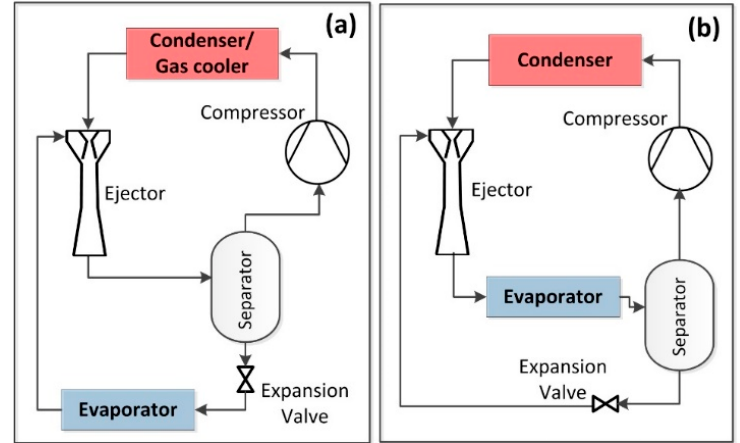
Figure 8. Refrigeration cycles with two-phase ejector: ( a ) ejector-expander (EERC); ( b ) ejector-recirculator (ERC).